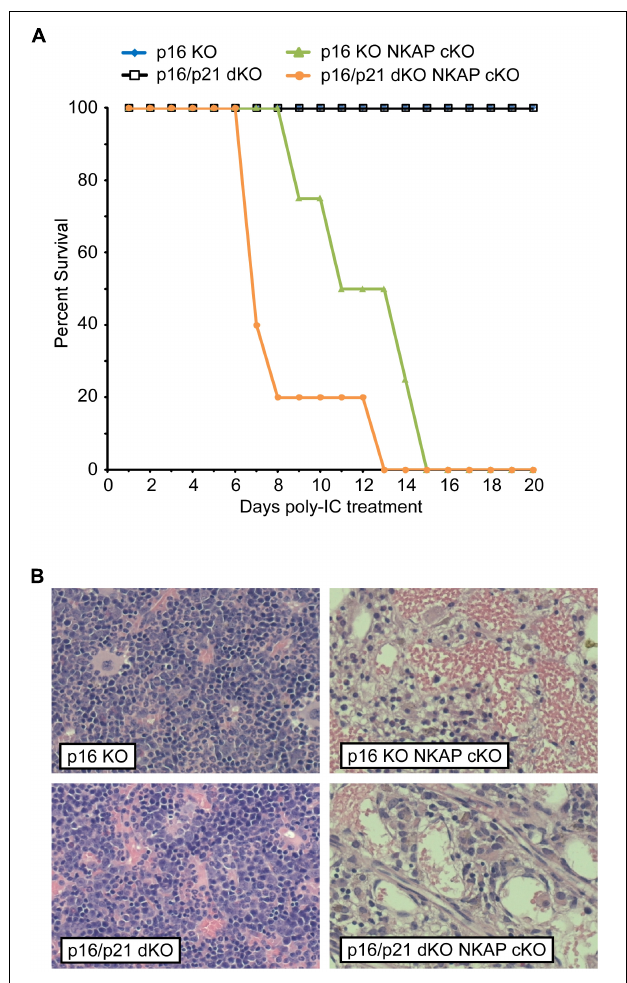
FIGURE 5 | Lethality and hematopoietic failure resulting from NKAP deficiency is not abrogated when CDKI upregulation is impaired. (A) Survival was examined in 8 p16 KO, 4 p16 KO Mx1-cre NKAP cKO, 5 p16/p21 dKO, and 6 p16/p21 dKO Mx1-cre NKAP cKO mice (see section “Materials and Methods” for nomenclature). All mice were treated with poly-IC and monitored daily for up to 20 days. Lethality was recorded if the mice were found dead or required euthanasia due to severe morbidity. The percent of mice in each group surviving to the day indicated by the horizontal axis is shown on the vertical axis. (B) Femurs from poly-IC treated mice of the indicated genotypes were fixed in formalin at the end of the time course and paraffin embedded sections were then generated and stained with hematoxylin and eosin. Brightfield images were obtained and prepared as in Figure 1 . Representative images are shown.